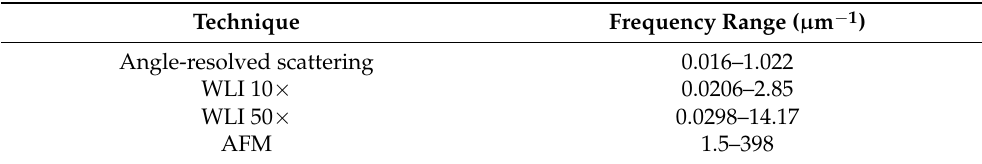
Figure 6. PSD measurement results with different techniques including WLI. Table 1. Frequency range for different